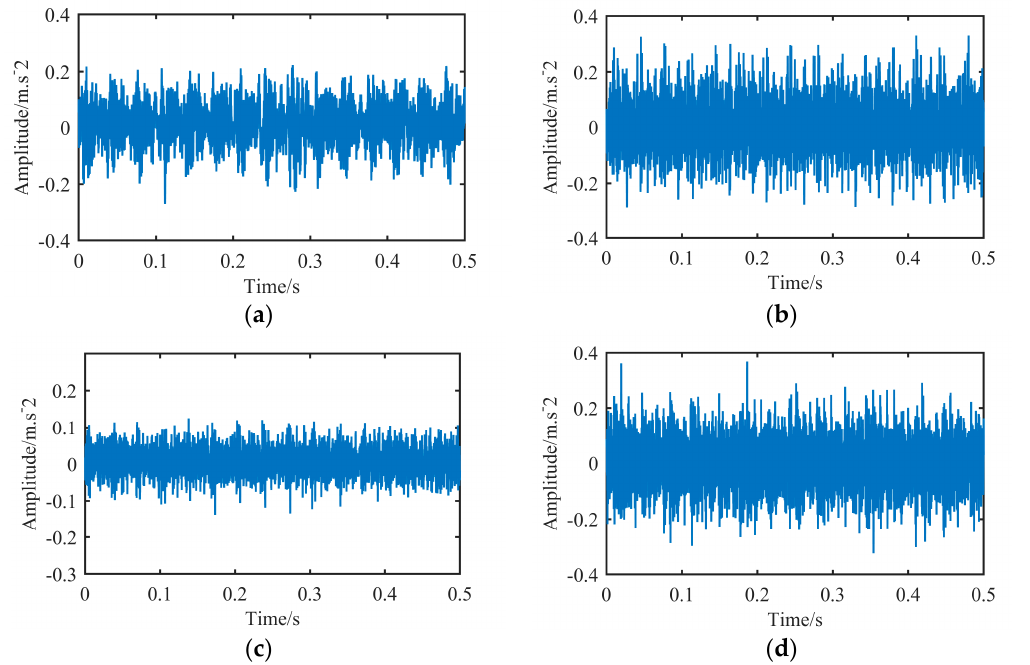
Figure 7. Vibration signals of rolling bearings in four states. ( a ) Normal state. ( b ) Inner ring fault. ( c ) Rolling body fault. ( d ) Outer ring fault. ( c ) Rolling body fault. ( d ) Outer ring fault.